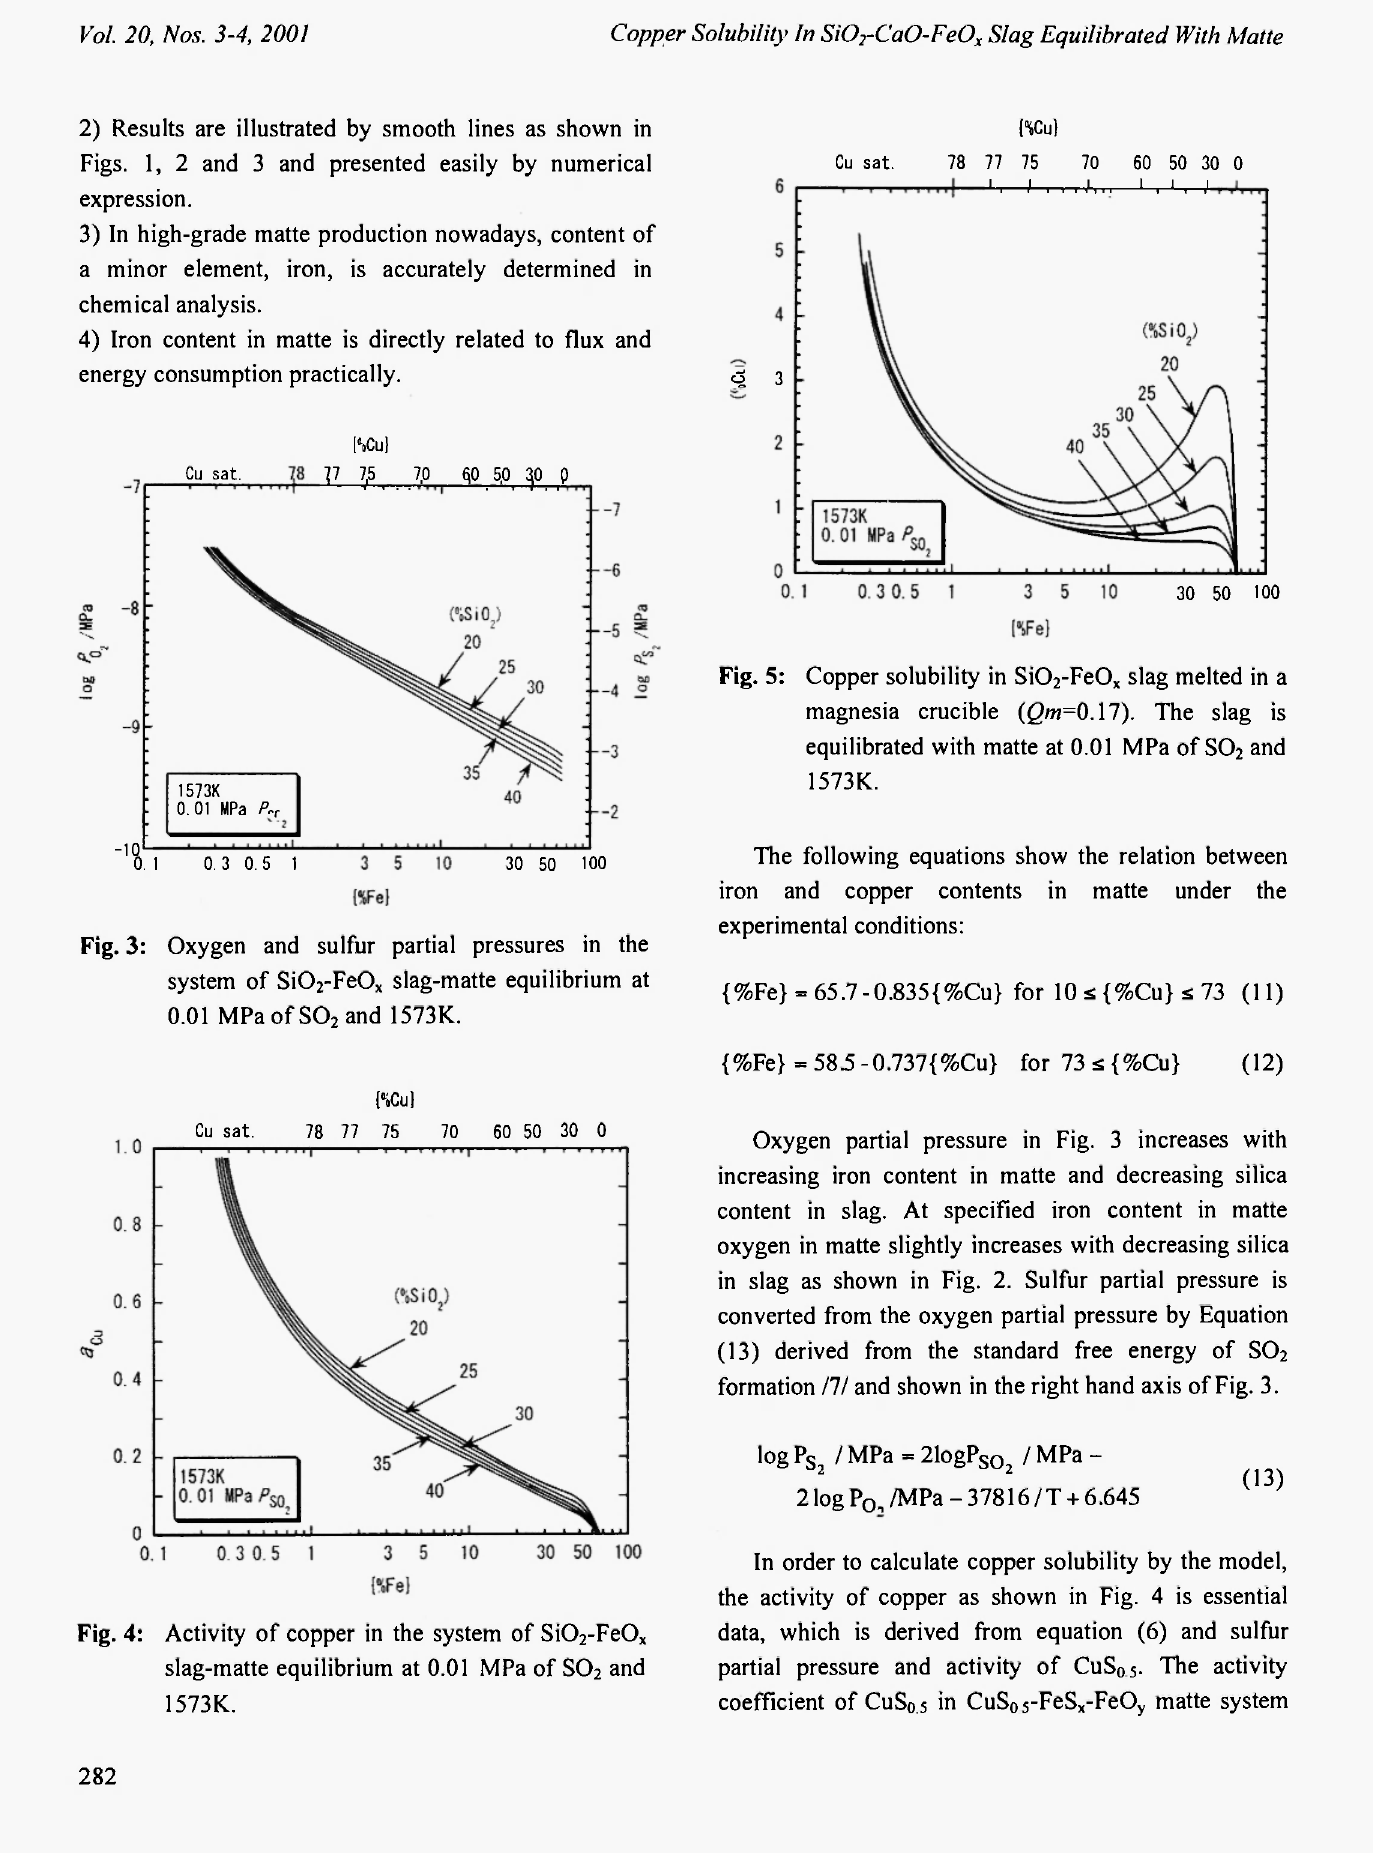
Fig. 4: Activity of copper in the system of Si0 2 -Fe0 x slag-matte equilibrium at 0.01 MPa of S0 2 and 1573K.